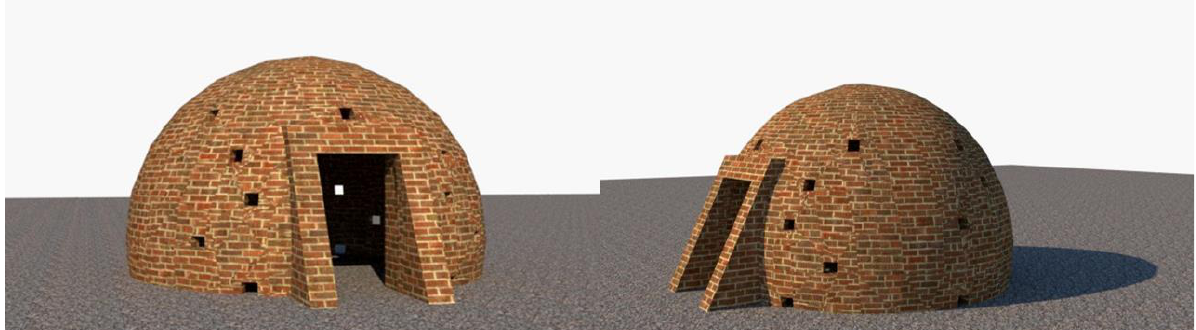
Figure 4. Design of an Argentinian half-orange kiln.